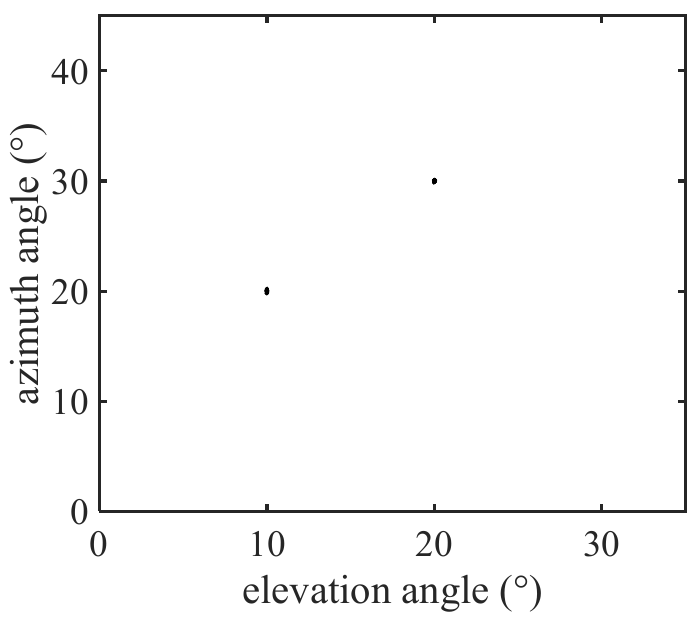
Figure 5. The scatter image of DOAs with TA ‐ MUSIC.